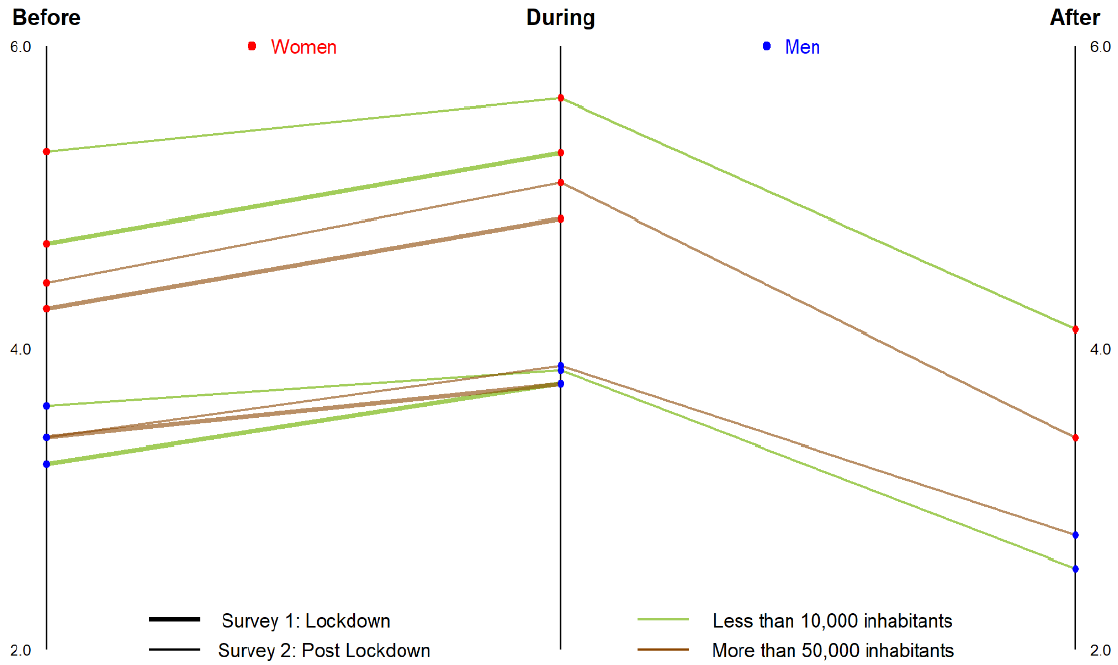
Figure 1. Averages of household chores completed per day by gender and time (relative to lockdown) in both surveys and in both municipality sizes.